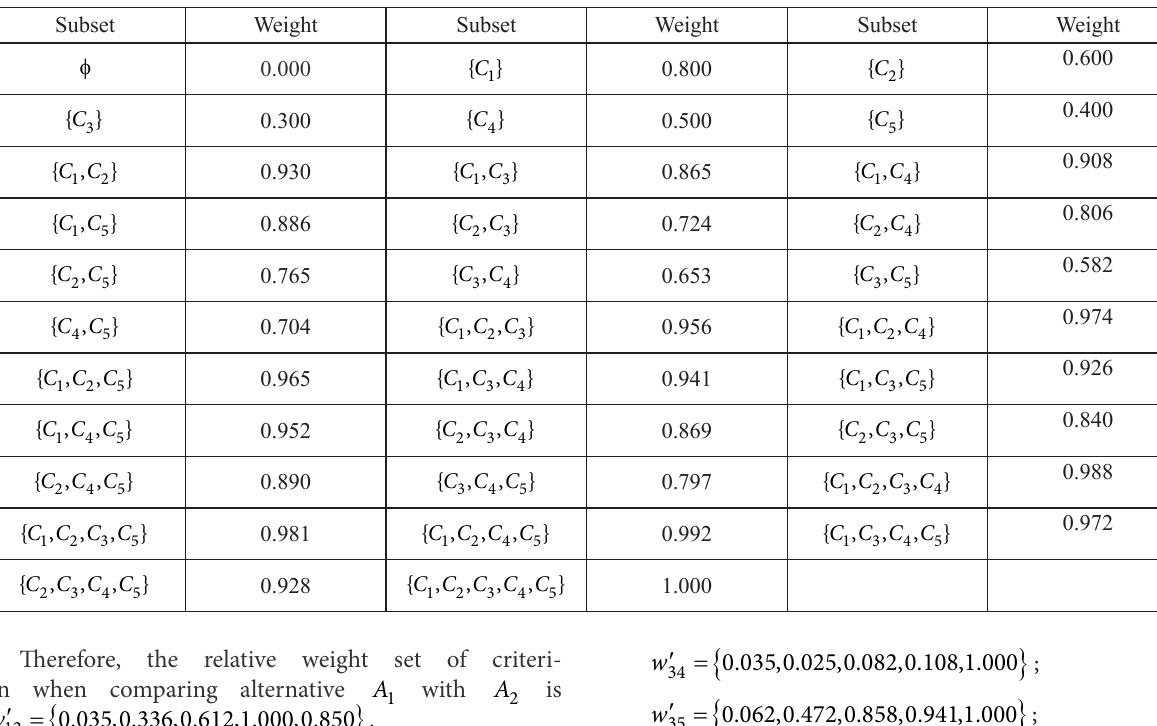
Table 3. Importance of each criterion